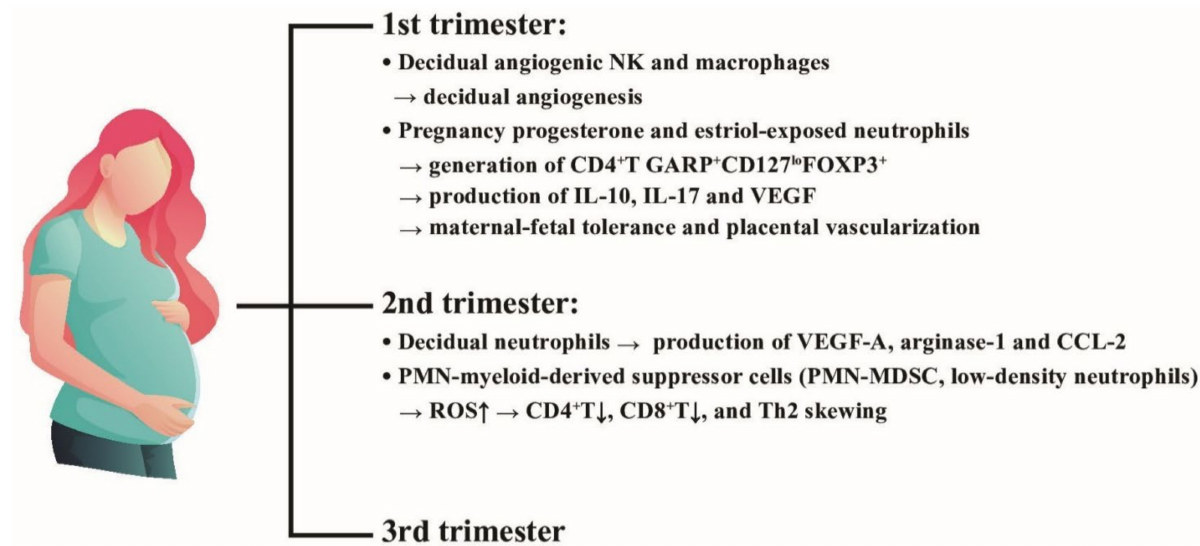
Figure 7. The effects of placental decidual neutrophils and neutrophil myeloid-derived suppressor cells (PMN-MDSC) on the placental angiogenesis and maternal-fetal tolerance in the first and second trimesters. NK: natural killer cells, ROS: reactive oxygen species, VEGF: vascular endothelial growth factor; CD: cluster of differentiation; IL: interleukin; FOXP3: Forkhead box P3; GARP: Glycoprotein-A Repetitions Predominant gene; CCL: cysteine-cysteine chemokine